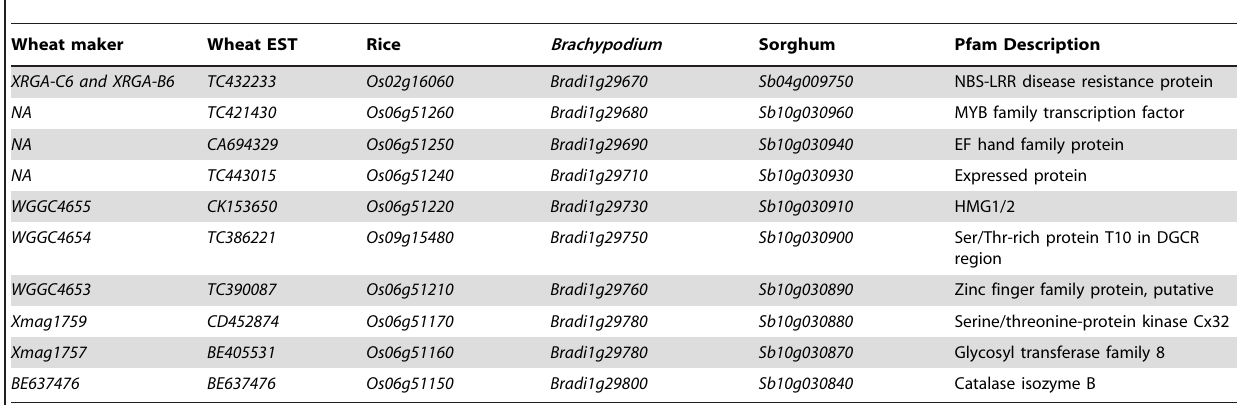
Table 1. Mapped wheat EST markers and ortholgous gene pairs among Brachypodium , rice and sorghum